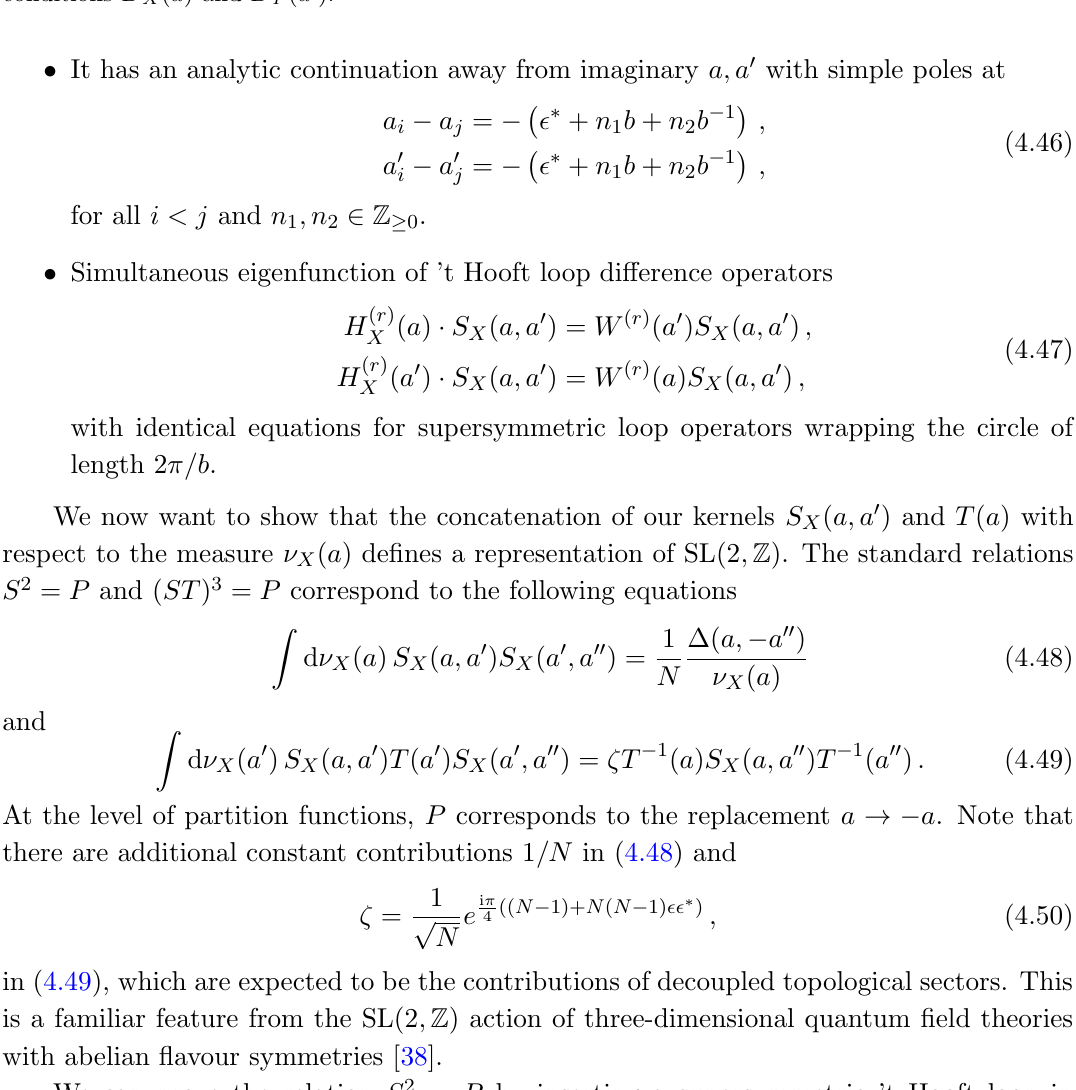
Figure 15 . The partition function of S duality interface between a pair of Dirichlet boundary conditions D X ( a ) and D Y ( a 0